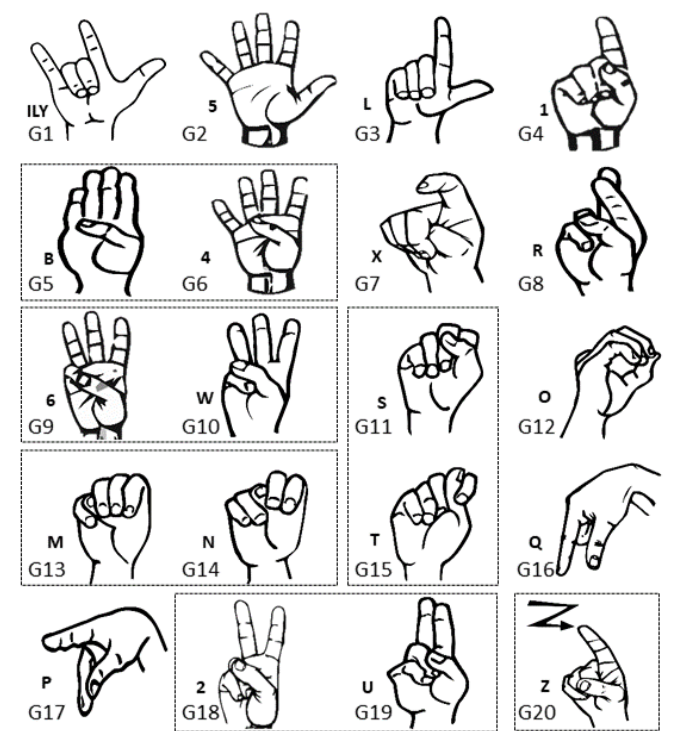
Figure 11. Data set of 20 ASL letters with expected high ambiguity, namely between “B” and “4”, “M” and “N”, “U” and “2”, “6” and “W”, “S” and “T”, and a dynamic sign “Z”.